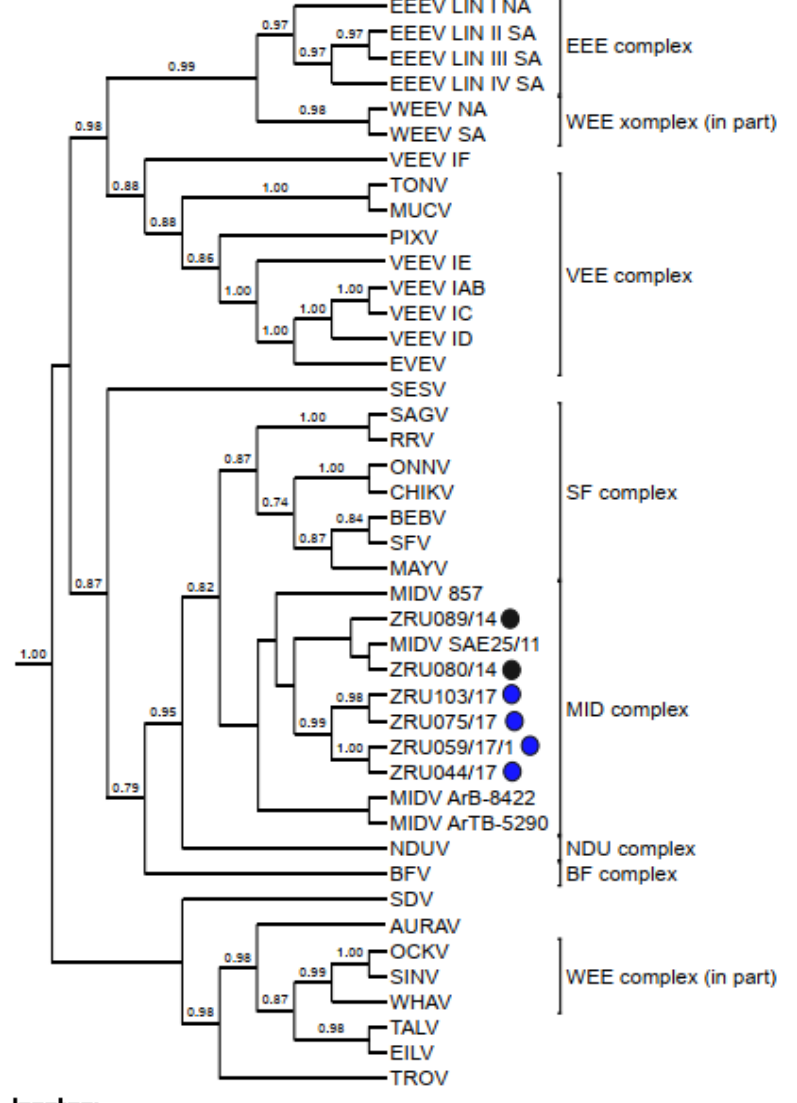
Figure 5. Rooted phylogenetic tree produced from Bayesian analysis using BEAST based on non- structural proteins (7236 base pairs) (33 taxa, model GTR+G+I) of alphaviruses is shown. Posterior probabilities >0.7 are shown on major branches. Sequences of horse Middelburg virus positives described in the current study are indicated with ZRU numbers and circle colours correspond to year sample was screened as follows: 2014 indicated in black (sequences obtained from whole blood samples) and 2017 (sequences obtained from culture isolates) indicated in blue. Alphavirus complexes are indicated by brackets. The tree is drawn to scale representing the number of nucleotide